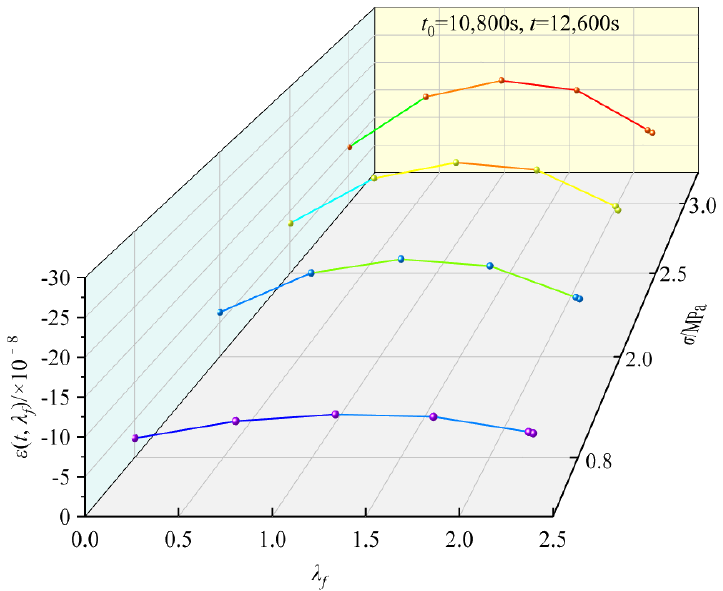
Figure 7. Relationship between creep rate and λ